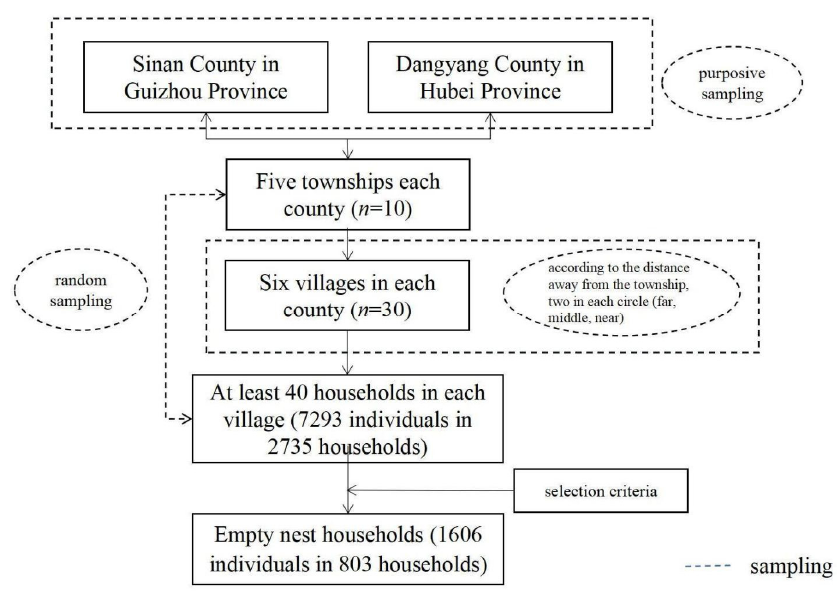
Figure 1. Selection process of empty nest households .